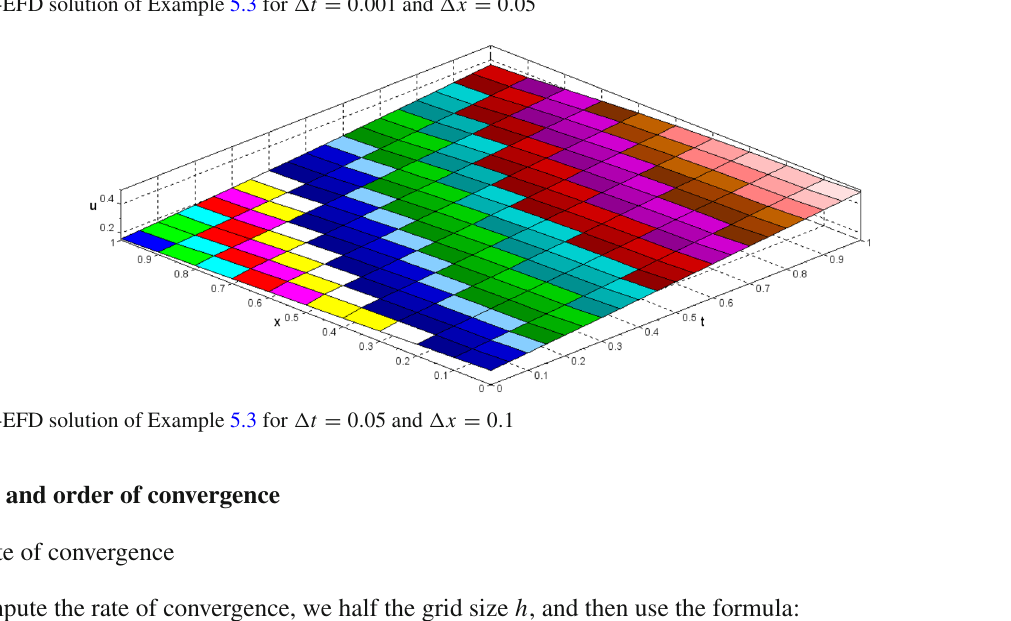
Fig. 5 I-EFD solution of Example 5.3 for (cid:2) t = 0 . 001 and (cid:2) x = 0 . 05